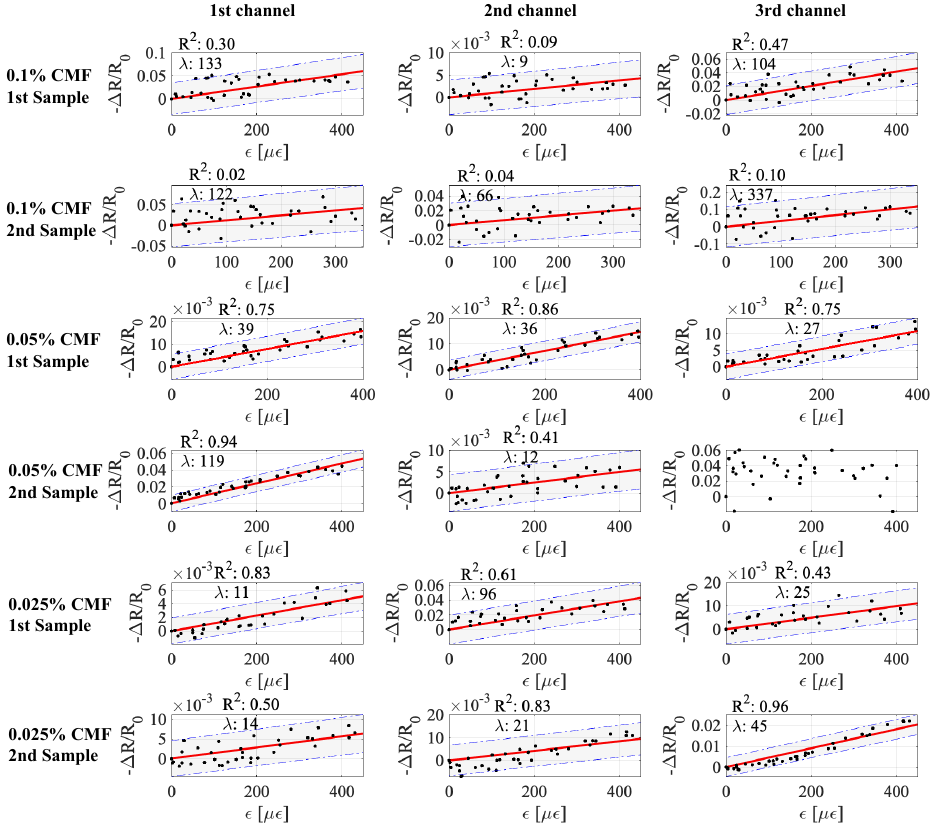
Figure 8. The established linear models of load sensing; rows contain signals from each sample, and columns contain the data obtained through measurement channels 1, 2, and